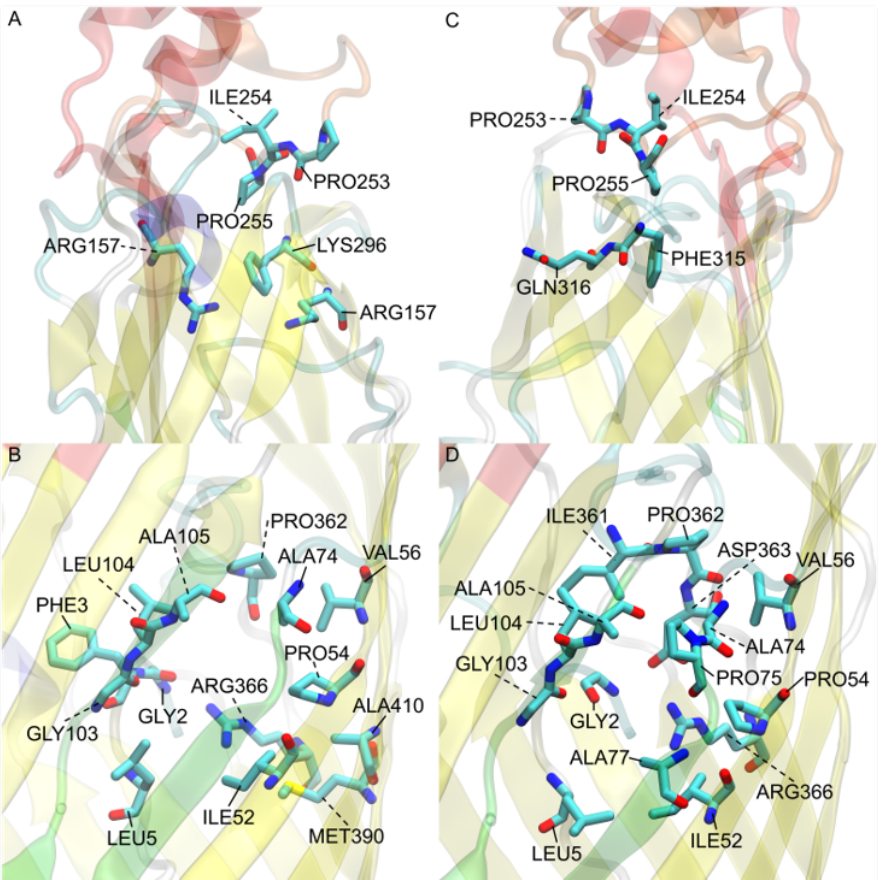
Figure 8. E. coli FadL binding residues of ( A ) 1T16 low affinity binding site residues, ( B ) 1T16 S3 kink, ( C ) E. coli low affinity binding site, and ( D ) E. coli S3 kink. The L3 loops are colored red, the L4 loops are colored orange, and the S3 kinks are colored green for reference. Perspective angles differ for easier observation of residues.